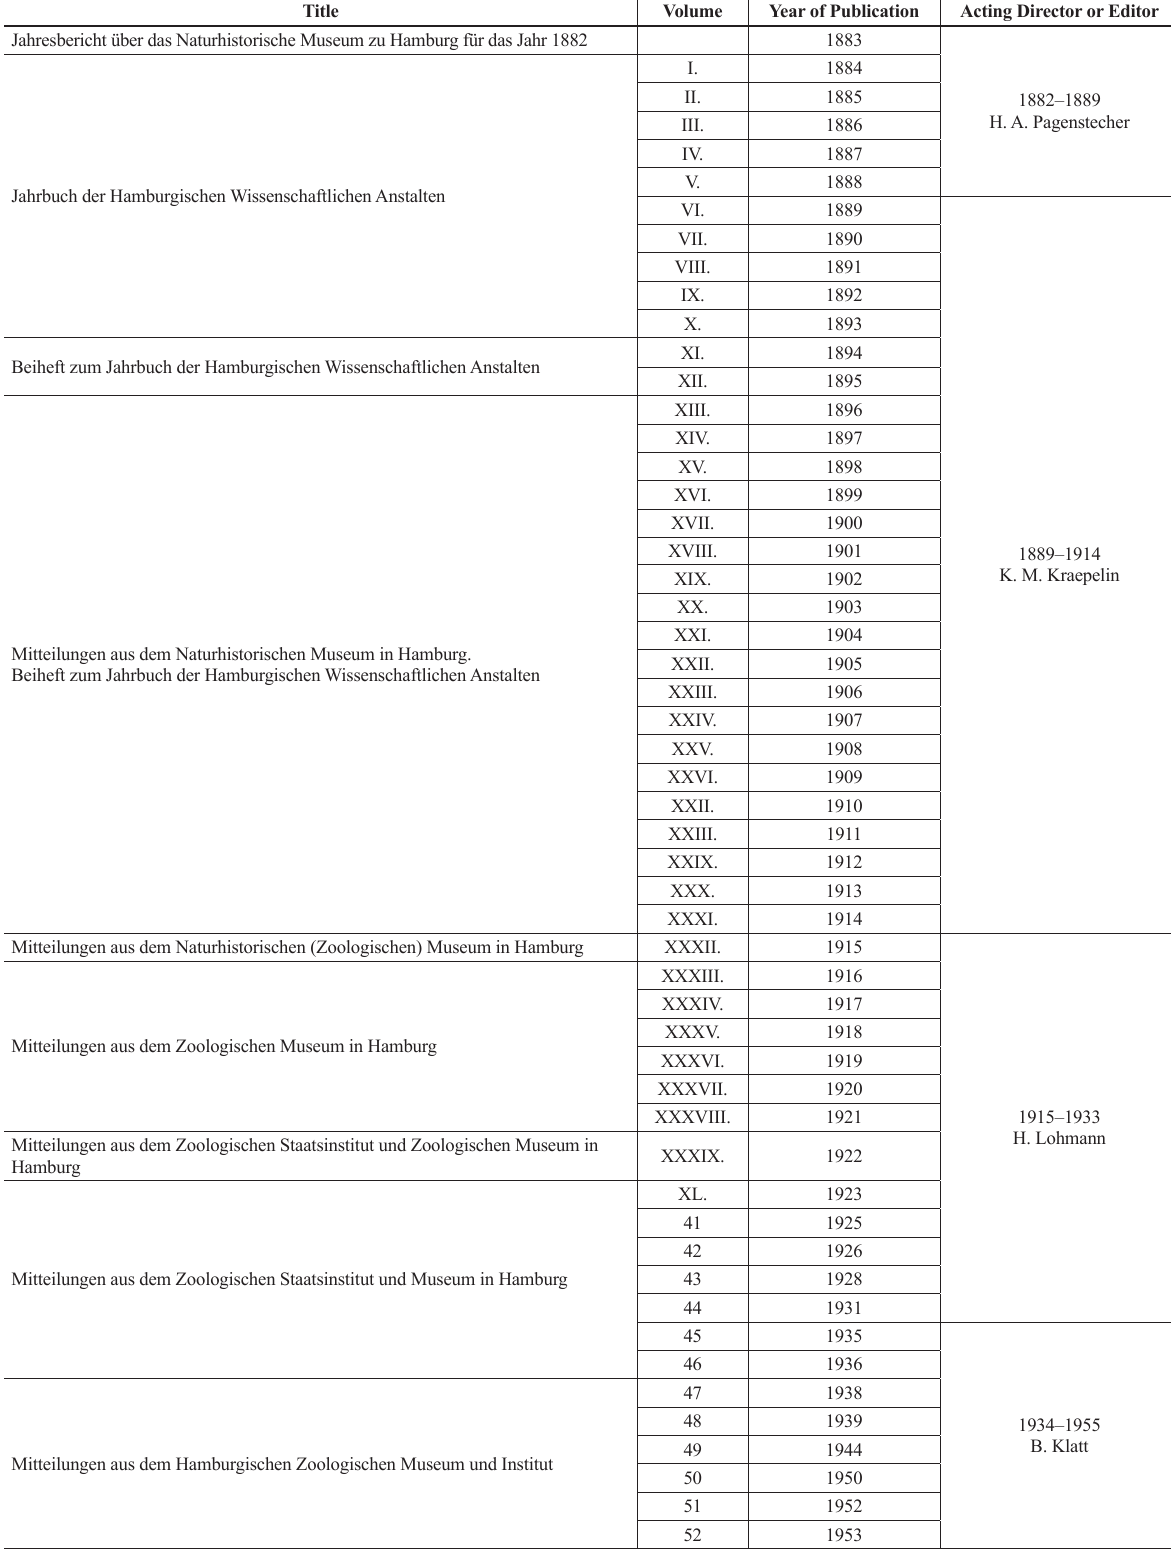
Table 1. The Hamburg natural history journal, published by the Naturhistorisches Museum and later the Zoological Museum in Hamburg, respectively; with its changing titles and volume numbers published from 1883 to 2010, as well as the periods of acting directors and later curators functioning as journal